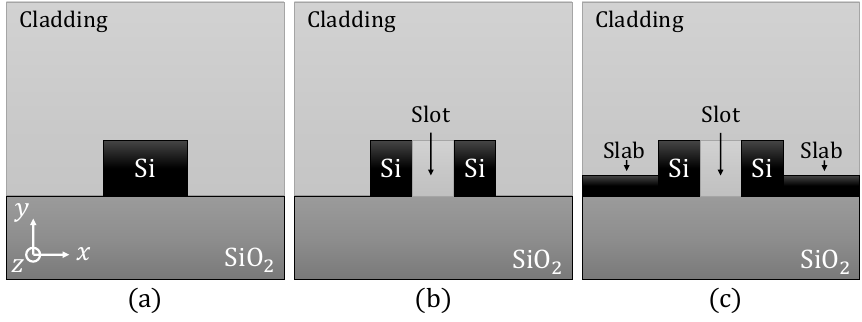
Figure 3. Cross sections of ( a ) conventional strip-waveguides, ( b ) slot-waveguides and ( c ) a slot-waveguide with slabs. The latter is the configuration studied in this